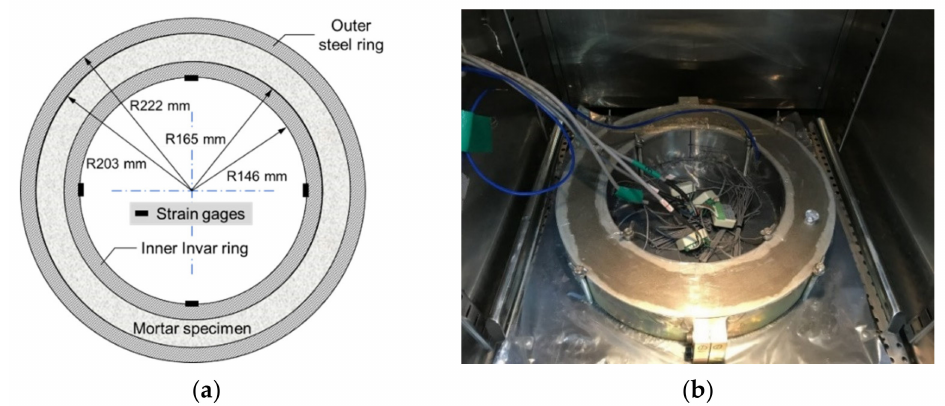
Figure 6. Restraining ring test apparatus: ( a ) geometry; ( b ) actual test setup.